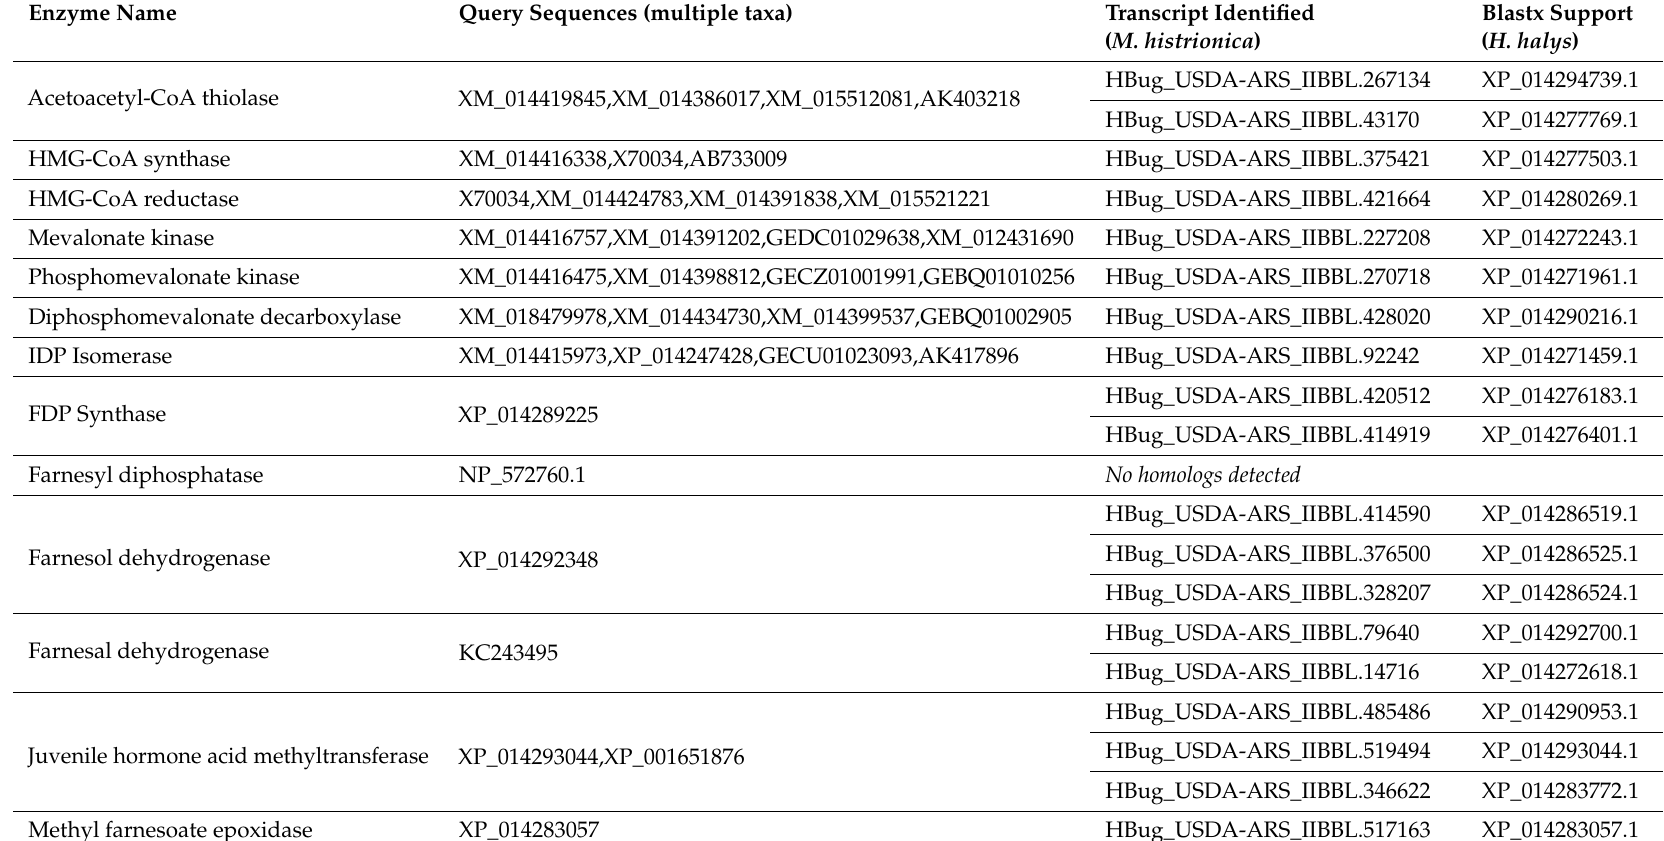
Table 5. M. histrionica PUTs encoding terpene biosynthesis-related genes (no genes for ubiquinone or dolichol biosynthesis were